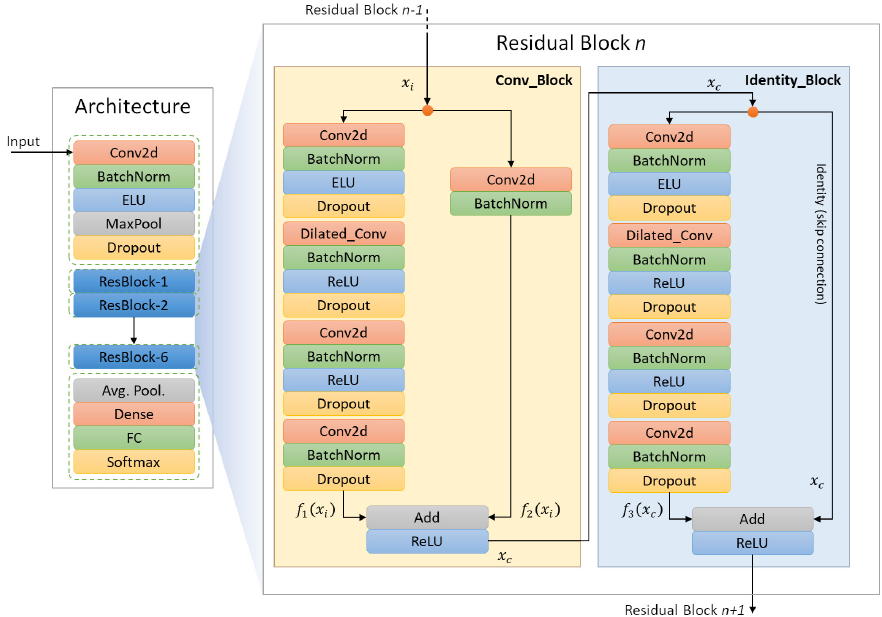
Figure 2. The LEMON Architecture pipeline and a representation of the residual bock including Convolution ( left ) and Identity Block ( right